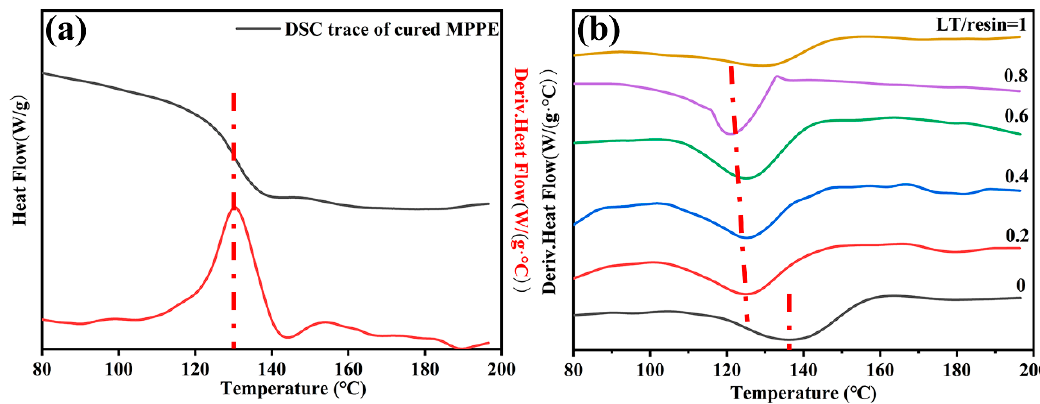
Figure 9. DSC curves of ( a ) cured MPPE and ( b ) LT-CCLs.